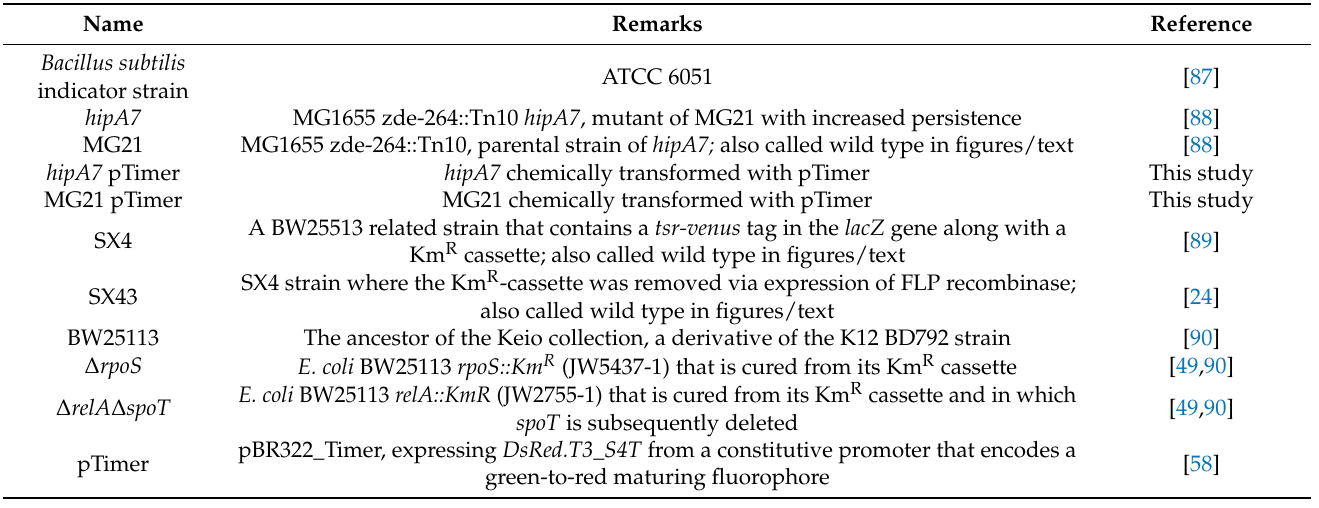
Table 1. Bacterial strains used in this